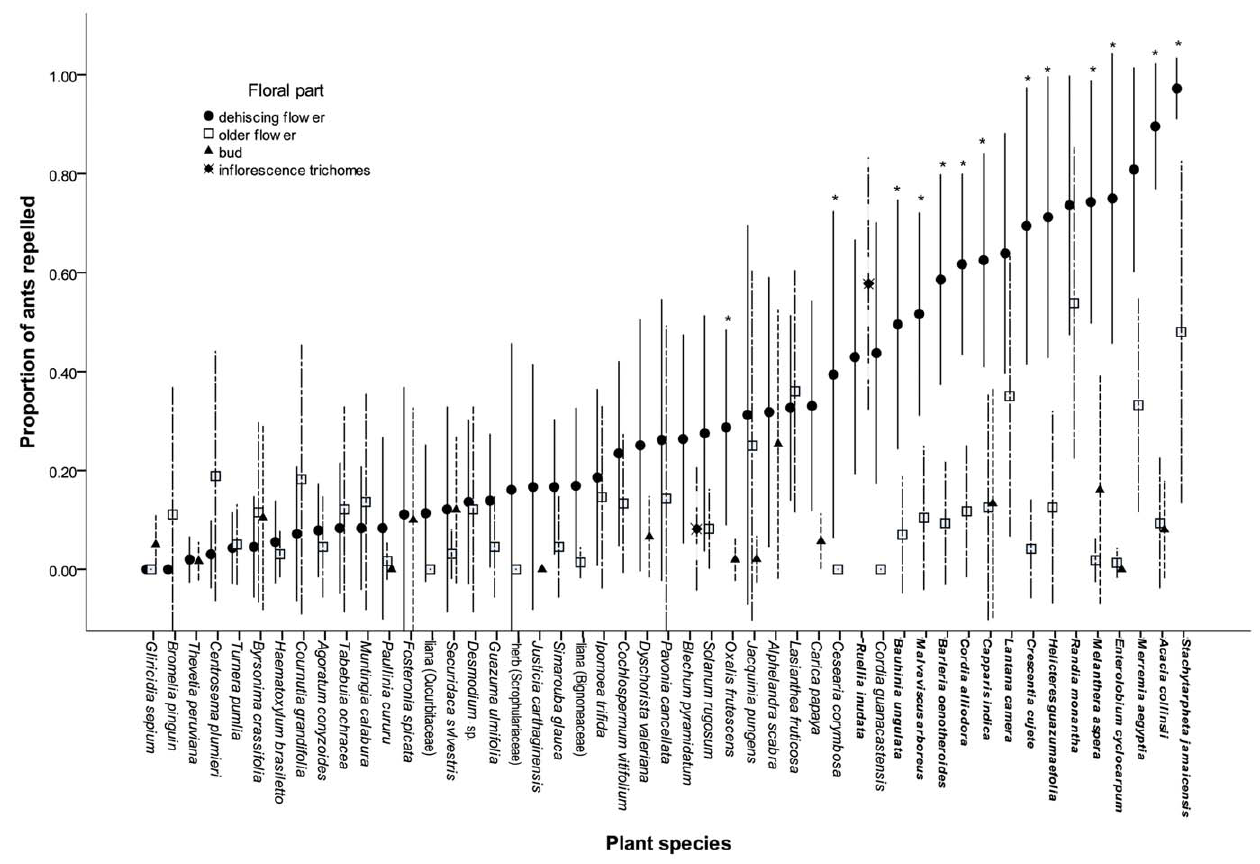
Figure 1. Tactile response results showing the mean proportion of Camponotusnovograndensis workers repelled by the fresh dehiscing floral parts and control parts of each plant species. Results arranged by increasing repellence from fresh flowers. In the case of Ruellia inudata and Blechum pyramidatum areas of inflorescence carrying trichomes were used. Floral parts of species in bold repelled ants on more than 50% of encounters and those marked * repelled ants significantly more from fresh flowers than control parts used (pollen-depleted flowers or buds). At least 12 replicates were carried out for each plant species. Error bars indicate 95% confidence intervals.